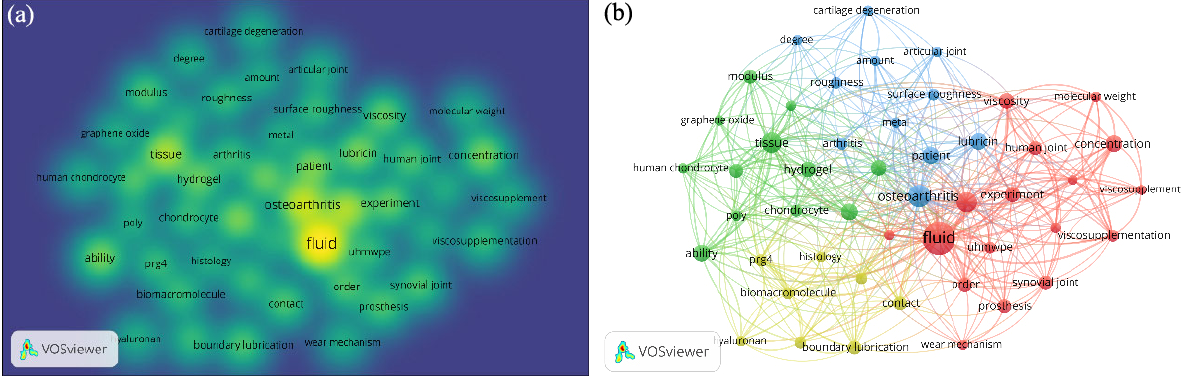
Fig. 39 (a) Density and (b) network diagrammes of